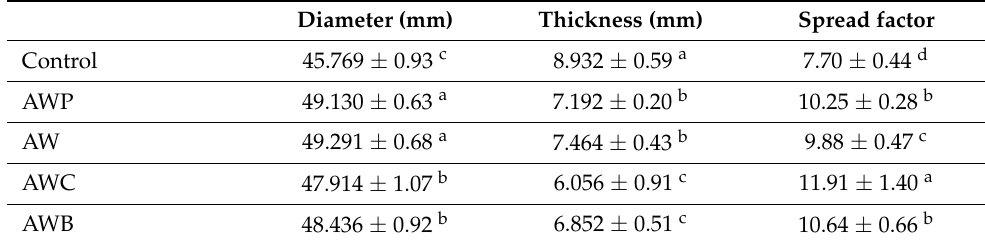
Table 5. Dimensions of the